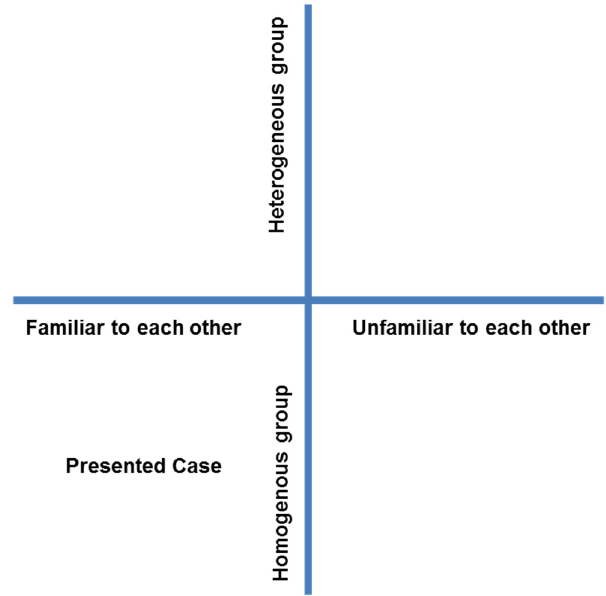
Figure Figure 3. The presented case study took place with a homogenous group that knew each other beforehand.